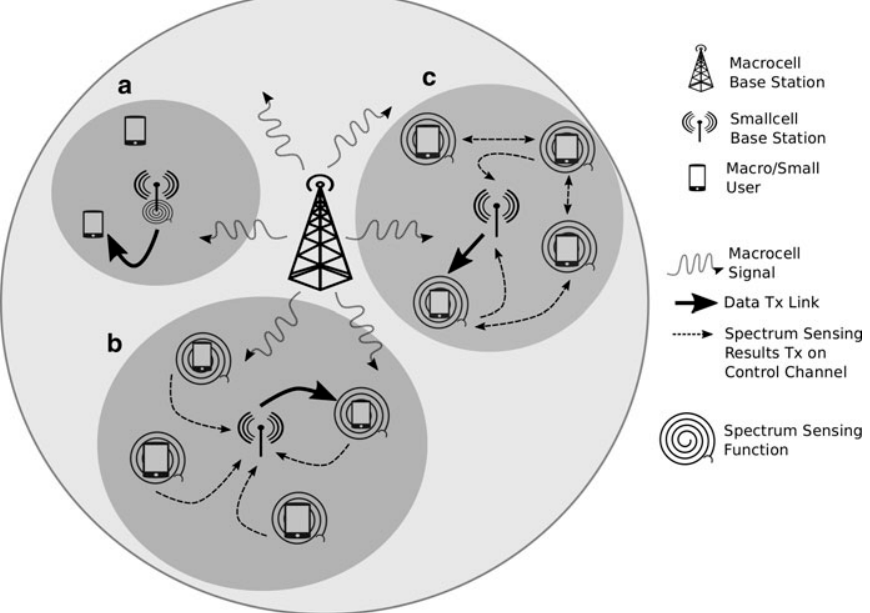
Figure 3. Cognitive Radio (CR)-based spectrum sensing.